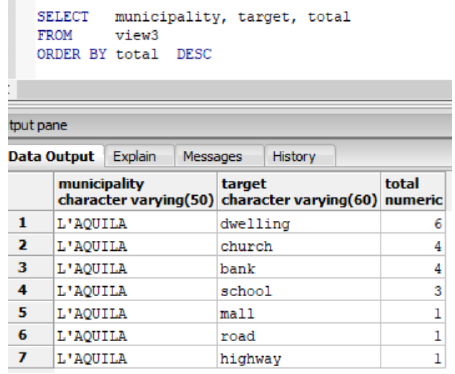
Figure 20. The ranking of damaged targets inside the municipality of